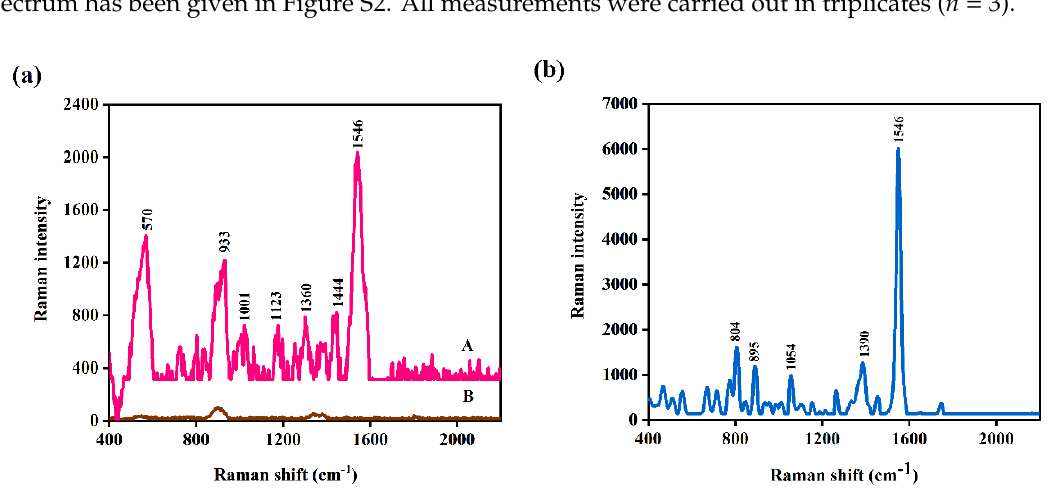
Figure 2. ( a ) Surface-enhanced Raman spectroscopy (SERS) spectra of ( A ) 200 µ g / mL (5 × 10 − 4 M) of meropenem (MPN) on plasmonic nickel foam, and ( B ) bare plasmonic nickel foam. ( b ) Direct Raman spectrum of raw MPN.